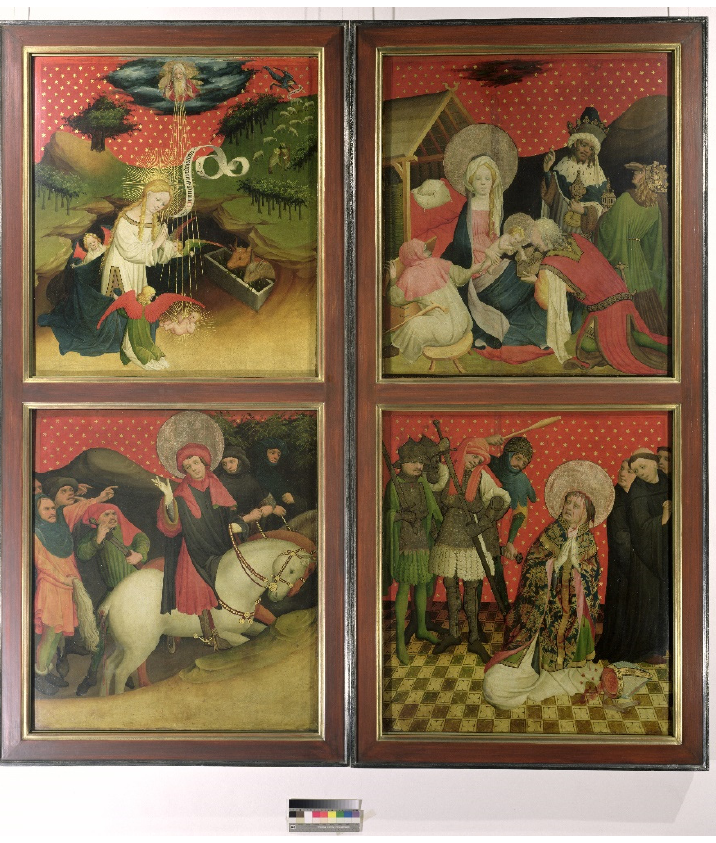
Figure 2. Meister Francke, Thomasaltar , closed position, tempera and oil on oak, each panel 99 × 89 cm, begun 1424. Photo: Hamburger Kunsthalle, Hamburg, Germany/Bridgeman Images.